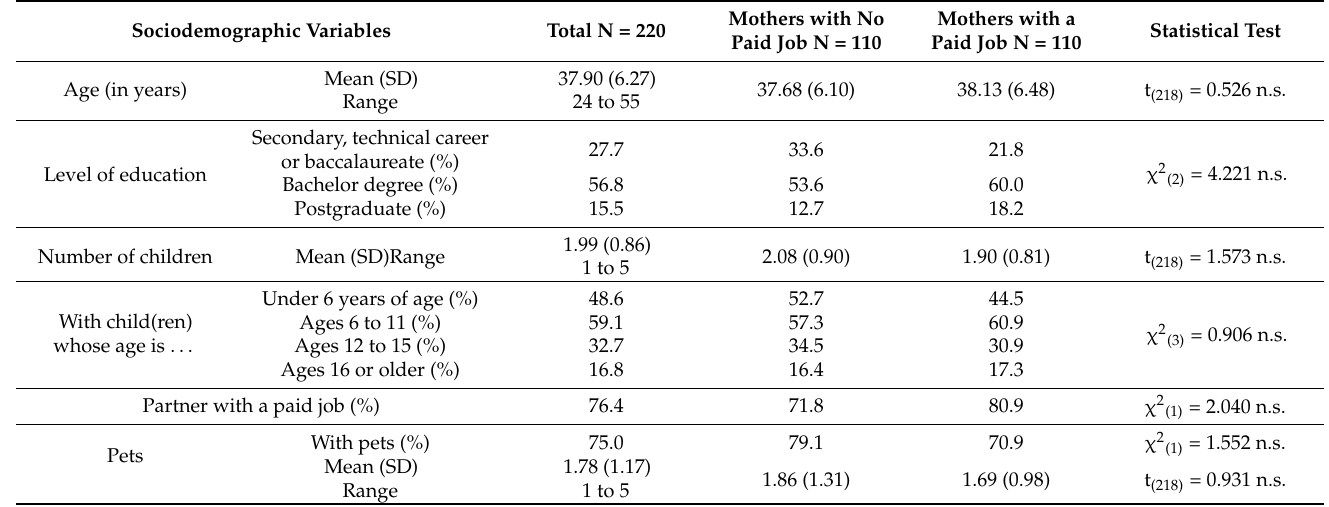
Table 1. Sociodemographic characteristics of the participants and proof of differences between mothers with and without a paid